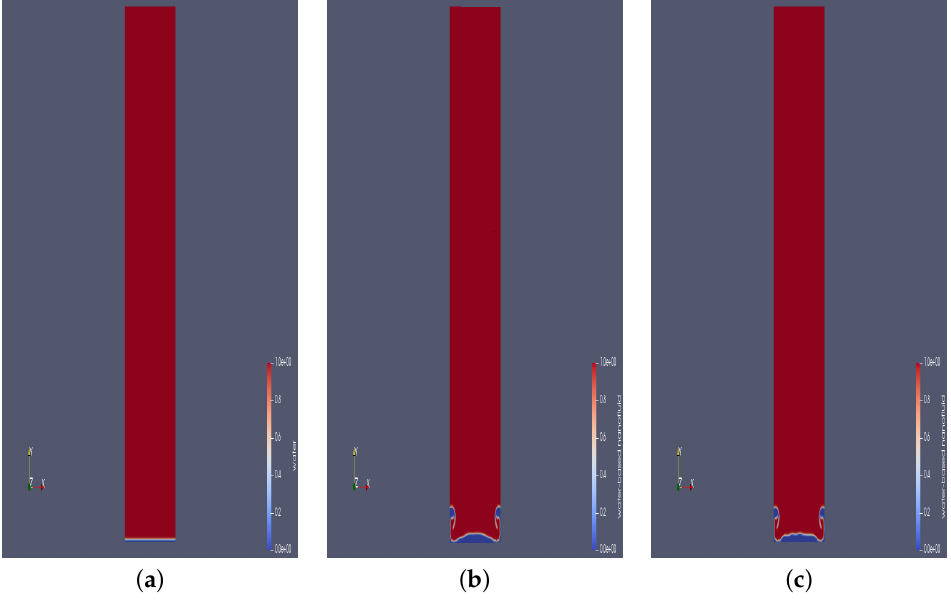
Figure 11. Snapshot of solutions for multi-phase mixtures at time t = 5 s. ( a ) Water. ( b ) Water-Al 2 O 3 nanofluid. ( c ) Water-TiO 2